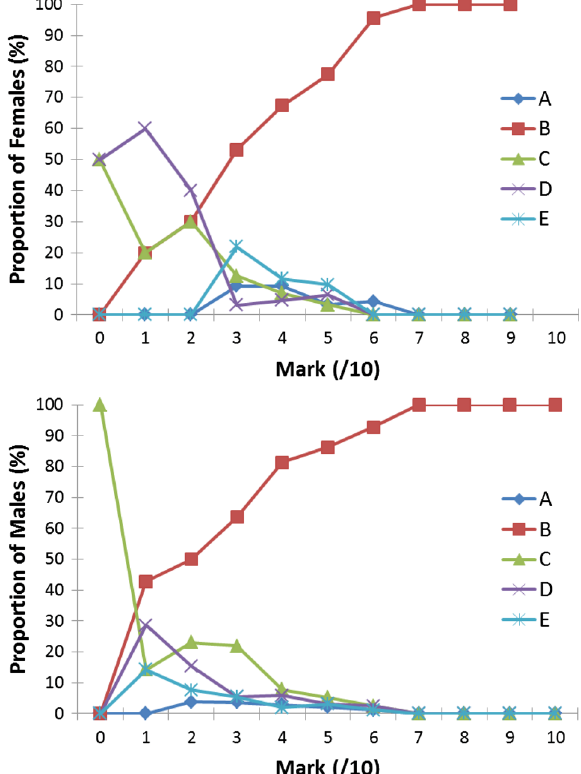
FIG. 6. Questions 1 and 2 from the 2010 ASOE. Question 1 showed a large gap in favor of males, while question 2 showed a large gaps in favor of females. FIG. 7. Item response curves for question 1 of the 2010 ASOE, kinetic energy and speed , for females (top) and males (bottom). No females achieved a score of 10 = 10 in